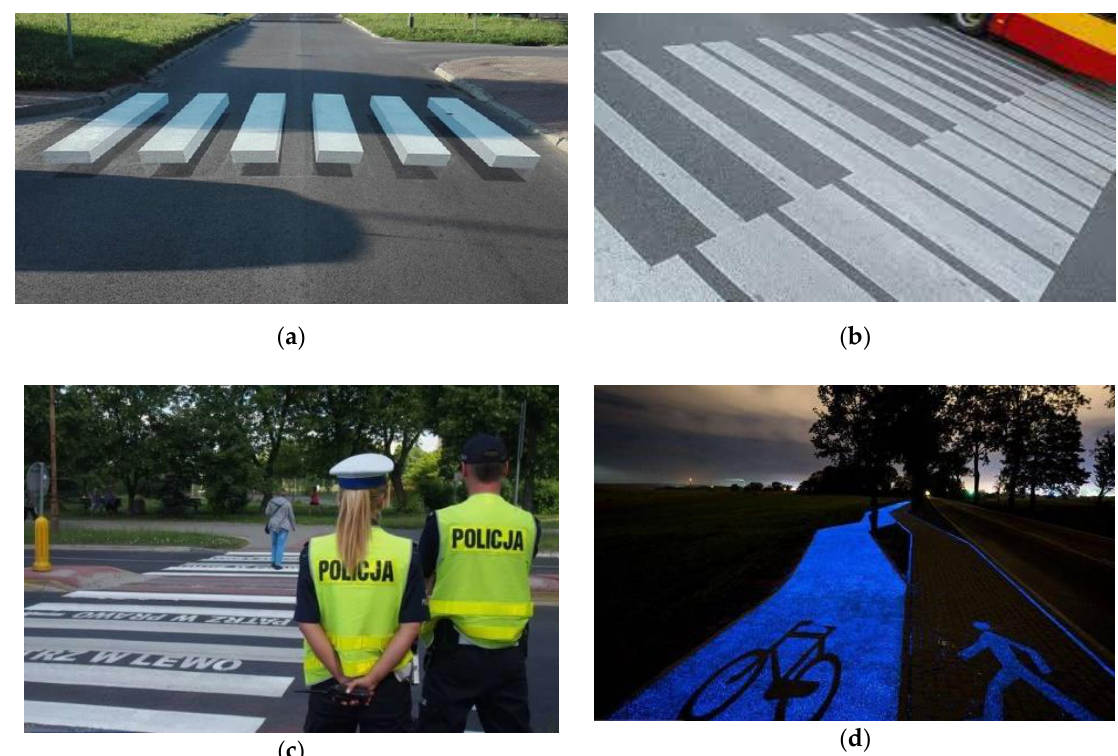
Figure 10. Examples of improving the visibility of pedestrian crossings: ( a ) Three-dimensional crossing, ( b ) piano/keyboard-styled pedestrian crossing (3DPKcrossing), ( c ) pedestrian crossings with hints. Reprinted with permission from ref. [52]. Copyright 2020 Lubuska Policja], ( d ) bicycle road and sidewalk visible at night.